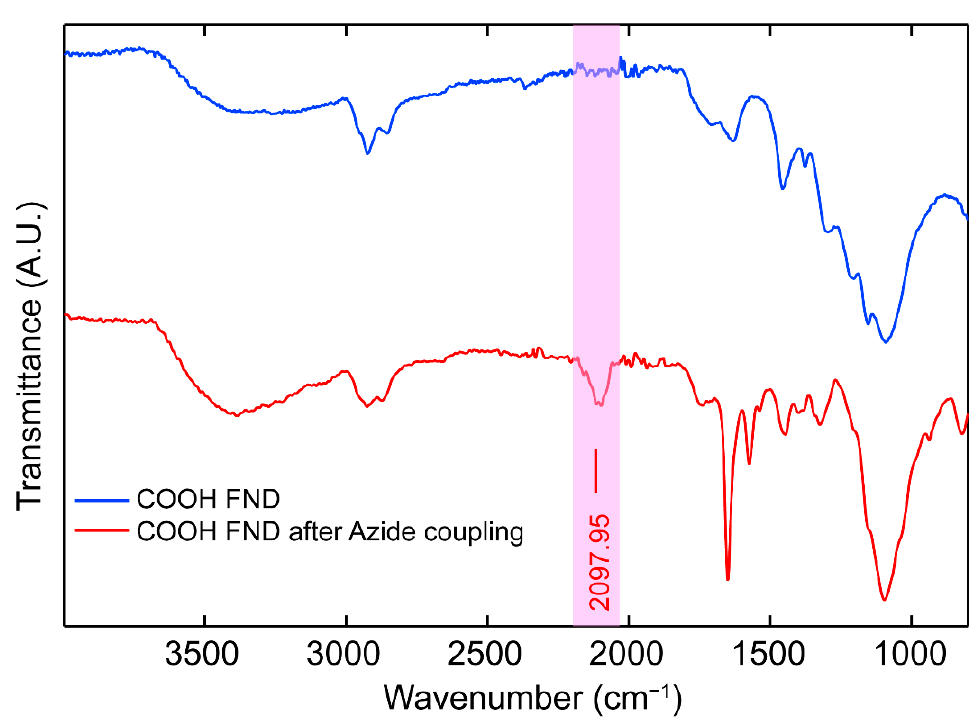
Figure 2. FTIR spectra of carboxylic acid enriched nanodiamonds (blue line). After coupling with amine–PEG–azide (red line), formation of the amide bond is observed via the amide I and amide II peaks at 1650 cm − 1 and 1570 cm − 1 , respectively, along with the azide stretching peak at ~2100 cm − 1 (pink